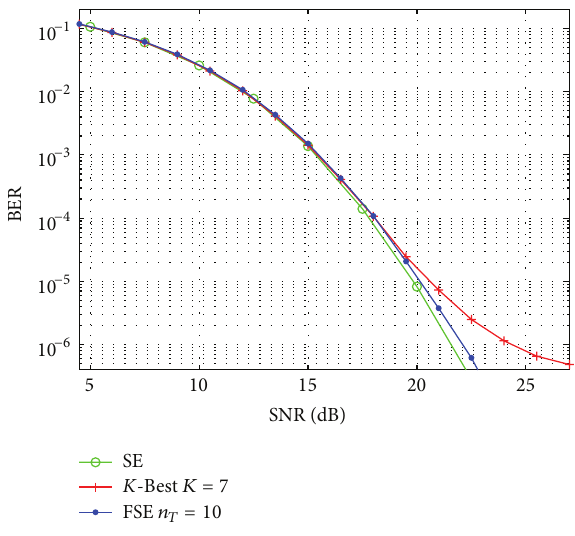
Figure 7: BER performance of the implemented FSE and K -best tree-search